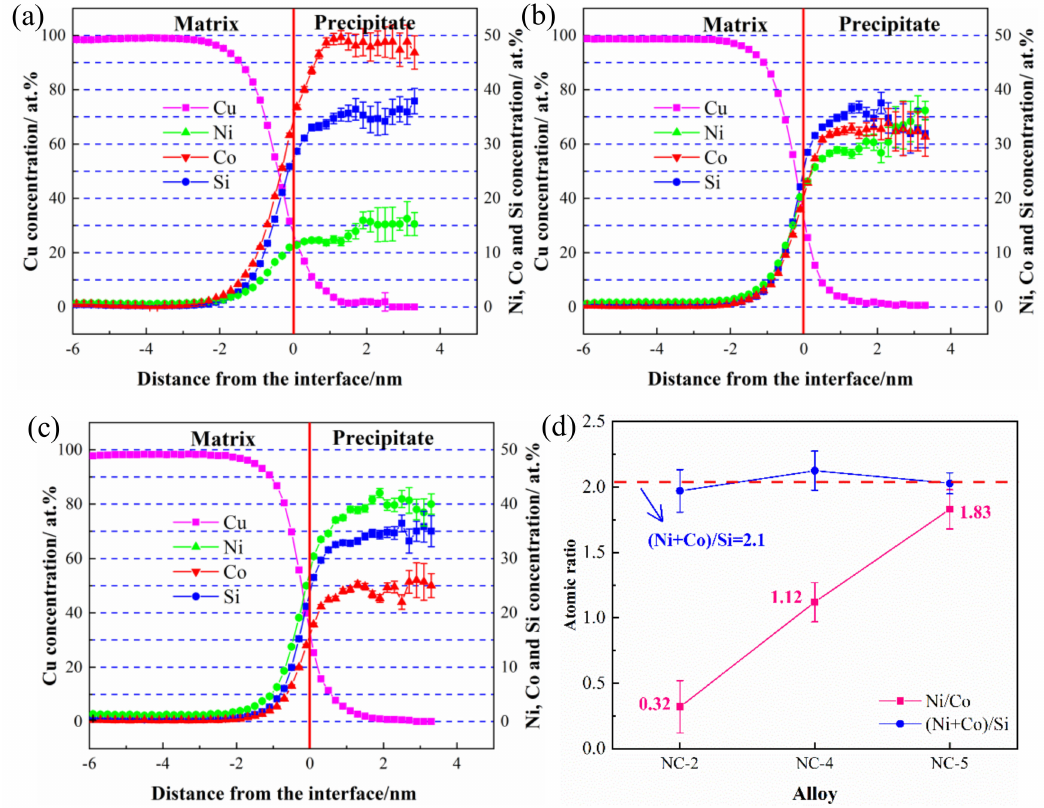
Figure 9. Atomic concentration distribution profiles of the studied alloy aged at 500 ◦ C for 1 h; ( a ) NC-2, ( b ) NC-4, ( c ) NC-5, and ( d ) variations of the Ni / Co and (Ni + Co) / Si atomic